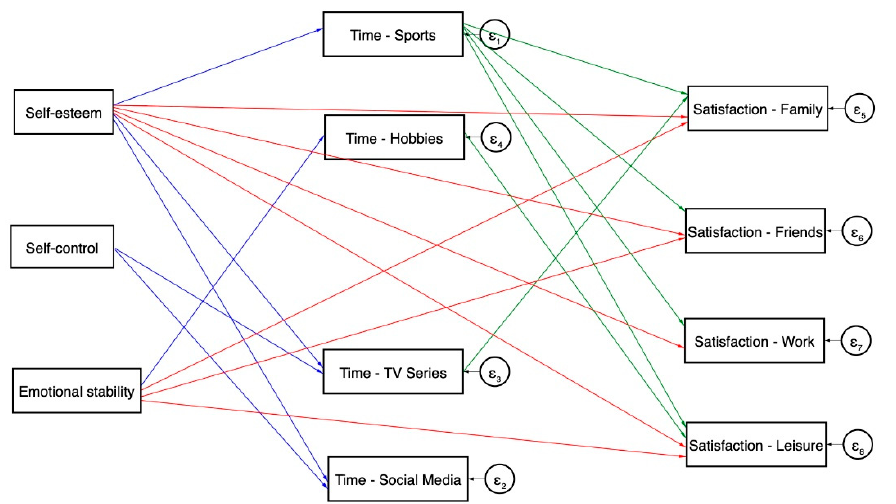
Figure 1. Direct effects tested in the structural equation model. Note: Blue arrows indicate the direct effects of psychological variables on time spent in different activities, red arrows indicate the direct effects of psychological variables on satisfaction on each area, and green arrows indicate the direct effect of the time spent for each leisure activity on the satisfaction on each area. Control variables (age, sex, and stringency) affecting activities and satisfaction are not shown.